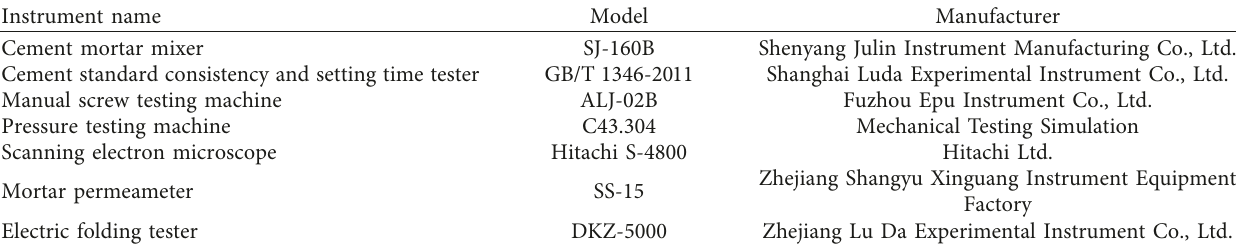
Table 2: Instruments used in this study.